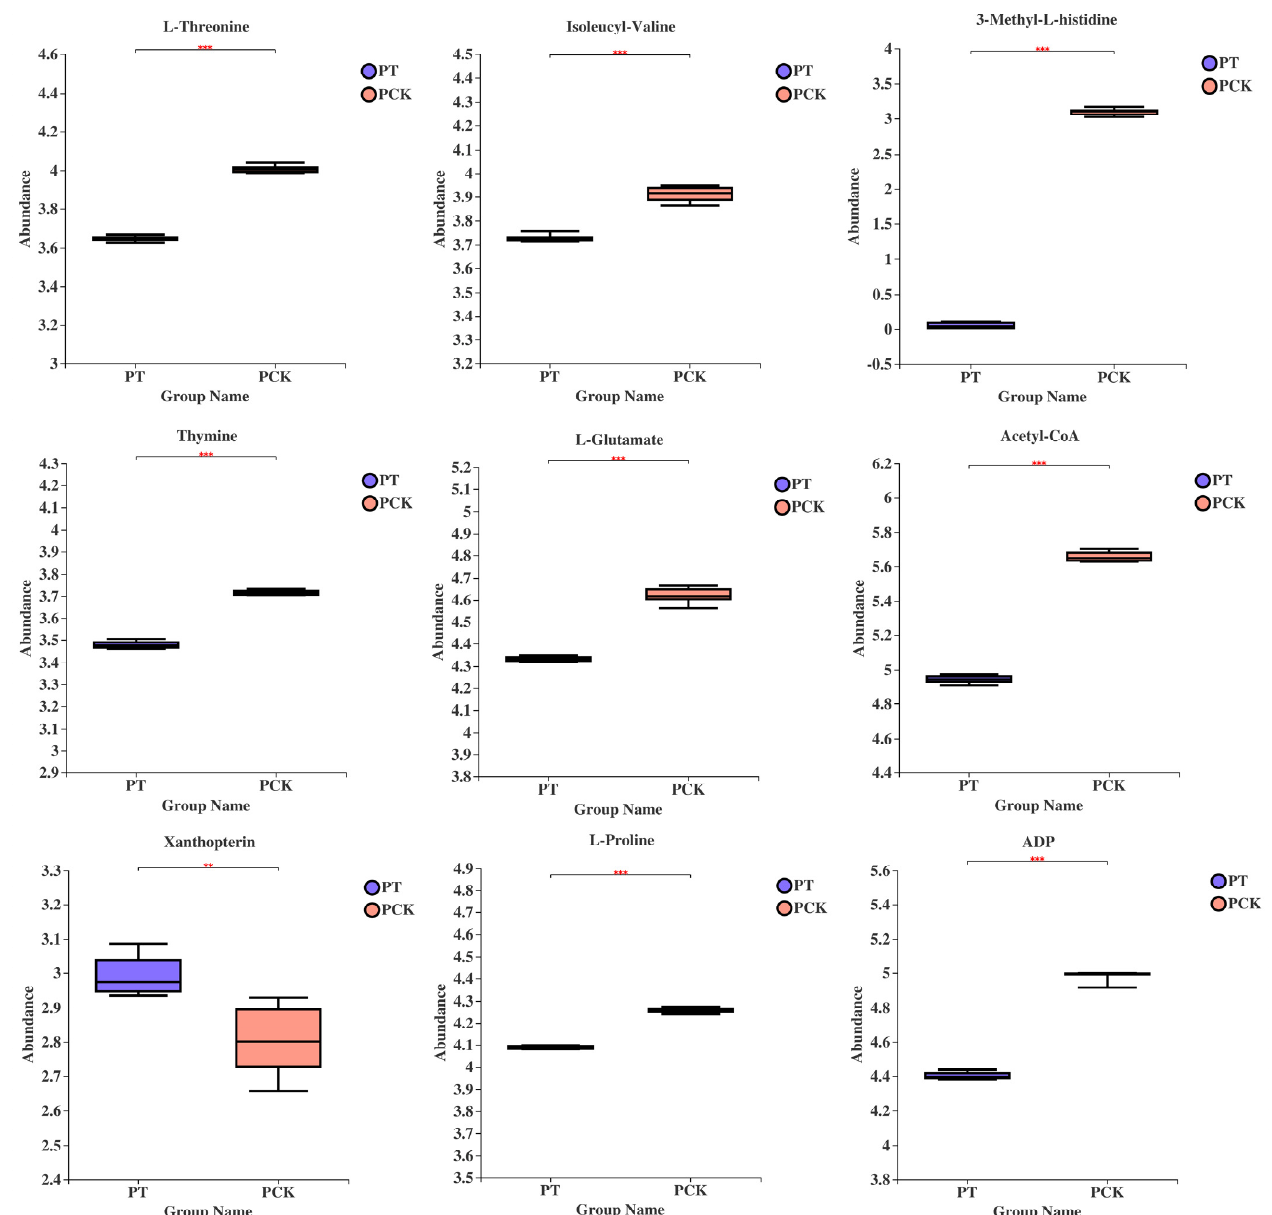
Figure 7. Box plot of some significantly different metabolite content levels in P. palleroniana treated (PT) or not treated (PCK) with 405 nm light illumination.